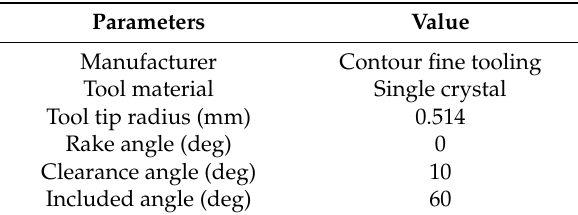
Table 3. Diamond tool parameters.